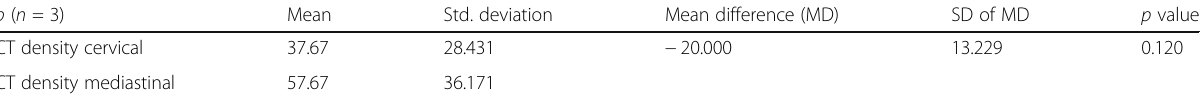
Table 3 Comparison of CT densities of cervical & mediastinal parts of thymus in 3 plain (non-contrast) CTs by Paired t test p ( n = 3)